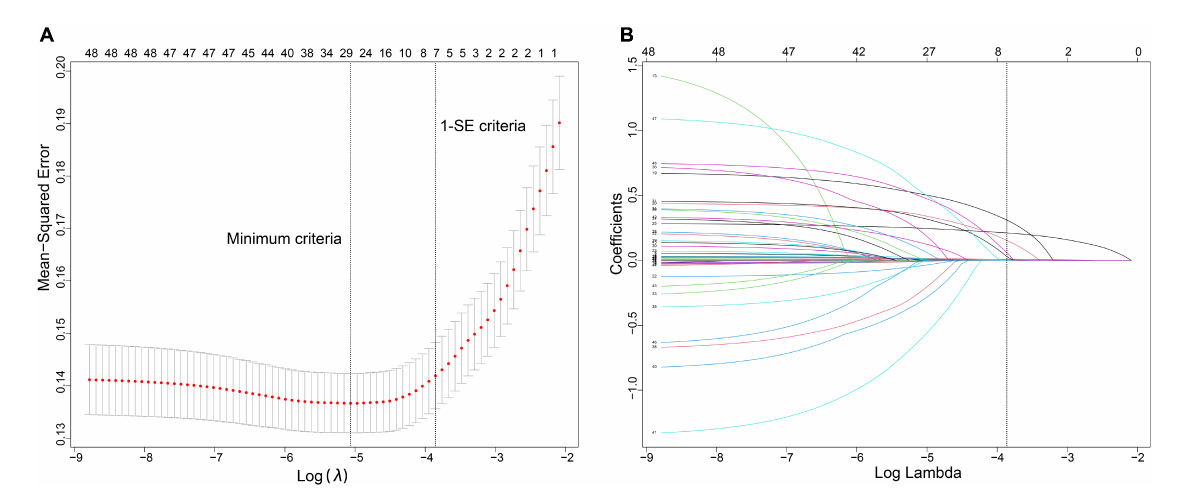
FIGURE2 Variable selection using the least absolute shrinkage and selection operator (LASSO) binary logistic regression model. (A) The tuning parameter ( λ ) in the LASSO model was selected for 10-fold cross-validation by the minimum criteria. The dotted vertical lines were drawn at the best values using the minimum criteria and 1 standard error of the minimum criteria (the 1-SE criteria). A λ -value of 0.021, with log ( λ ), –3.855 was chosen (1-SE criteria) according to 10-fold cross-validation. (B) LASSO coefficient curves of the 48 variables. A coefficient profile plot was produced against the log ( λ ) sequence. Vertical line was drawn at the value selected using 10-fold cross-validation, where optimal λ resulted in 7 non-zero